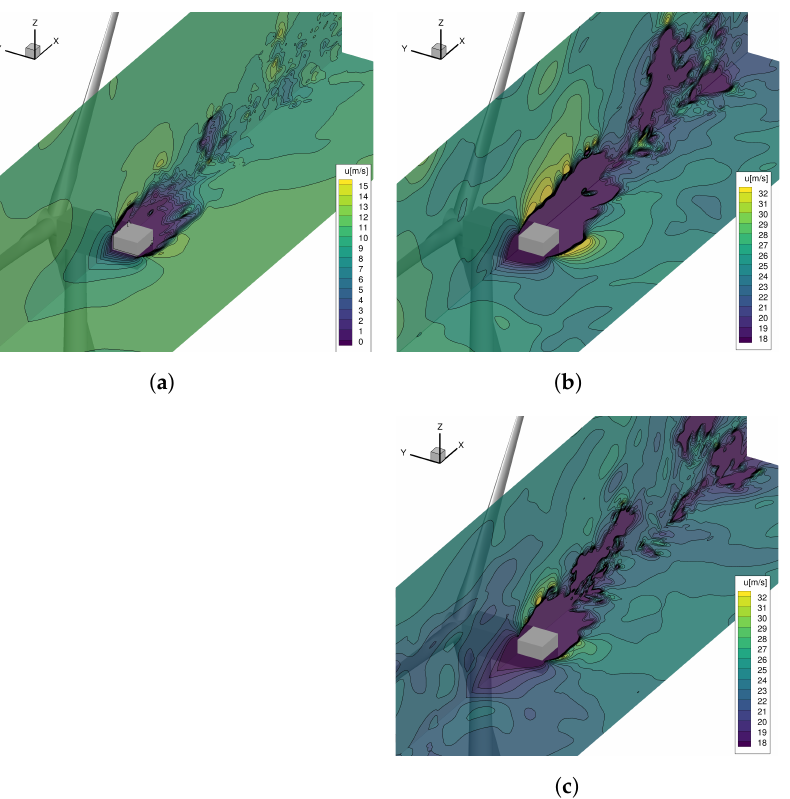
Figure 10. Instantaneous streamwise velocity of WT wake flow field (OS-2). ( a ) C4 − V W = 11.3m/s;